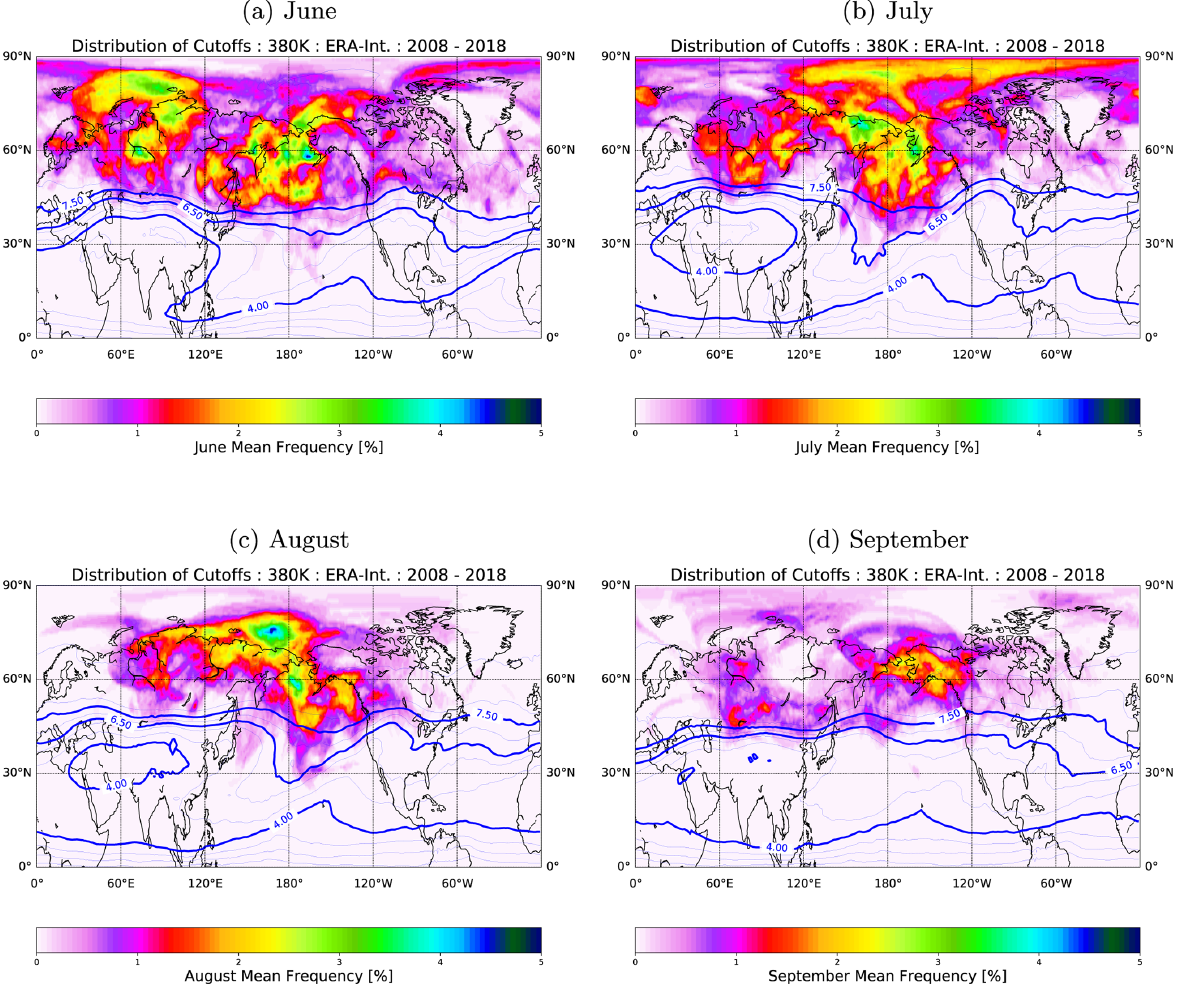
Figure B1. Global climatological frequency distribution of ASMA-related 7.5PVU cutoffs for each month in JJAS.